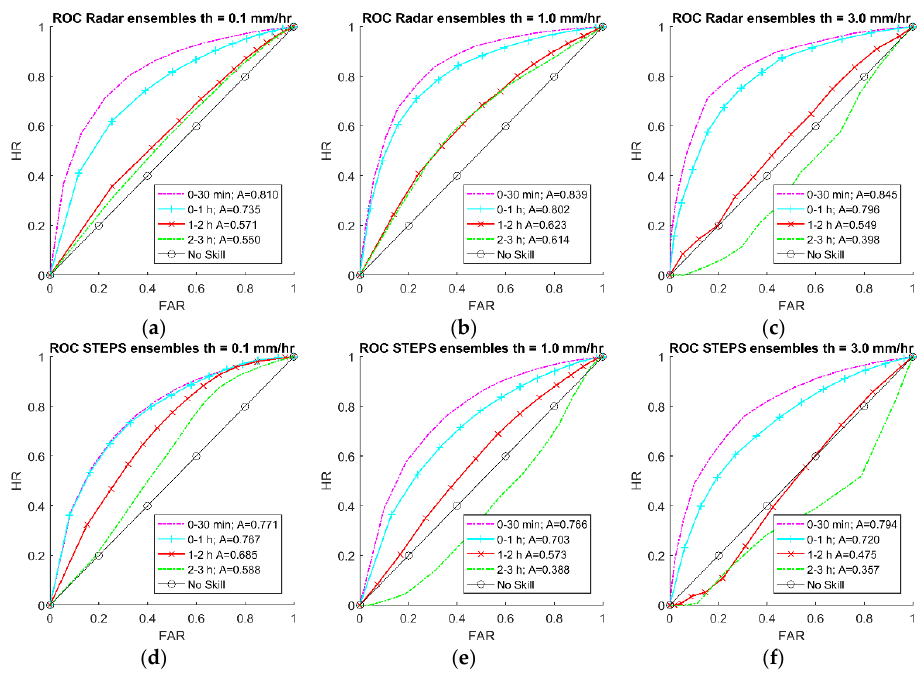
Figure 4. Receiving Operating Characteristic (ROC) curves for event on 7 July 2008 starting at 15:00 for Radar ensembles and rainfall thresholds (th) equal to 0.1 mm/h ( a ), 1.0 mm/h ( b ) and 3.0 mm/h ( c ). and Short-Term Ensemble Prediction System (STEPS) ensembles and rainfall thresholds equal to 0.1 mm/h ( d ), 1.0 mm/h ( e ) and 3.0 mm/h ( f ).